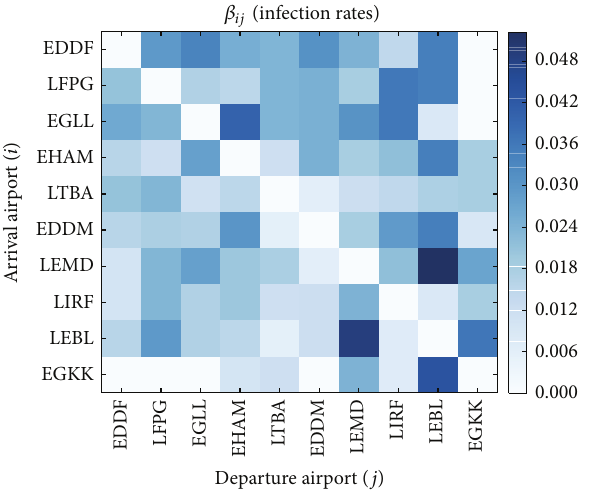
Figure 2: Infection rates 𝛽 𝑖𝑗 between 10 busiest airports in Europe calculated throught the movements between 13:30 and 16:30 on June 02, 2015.